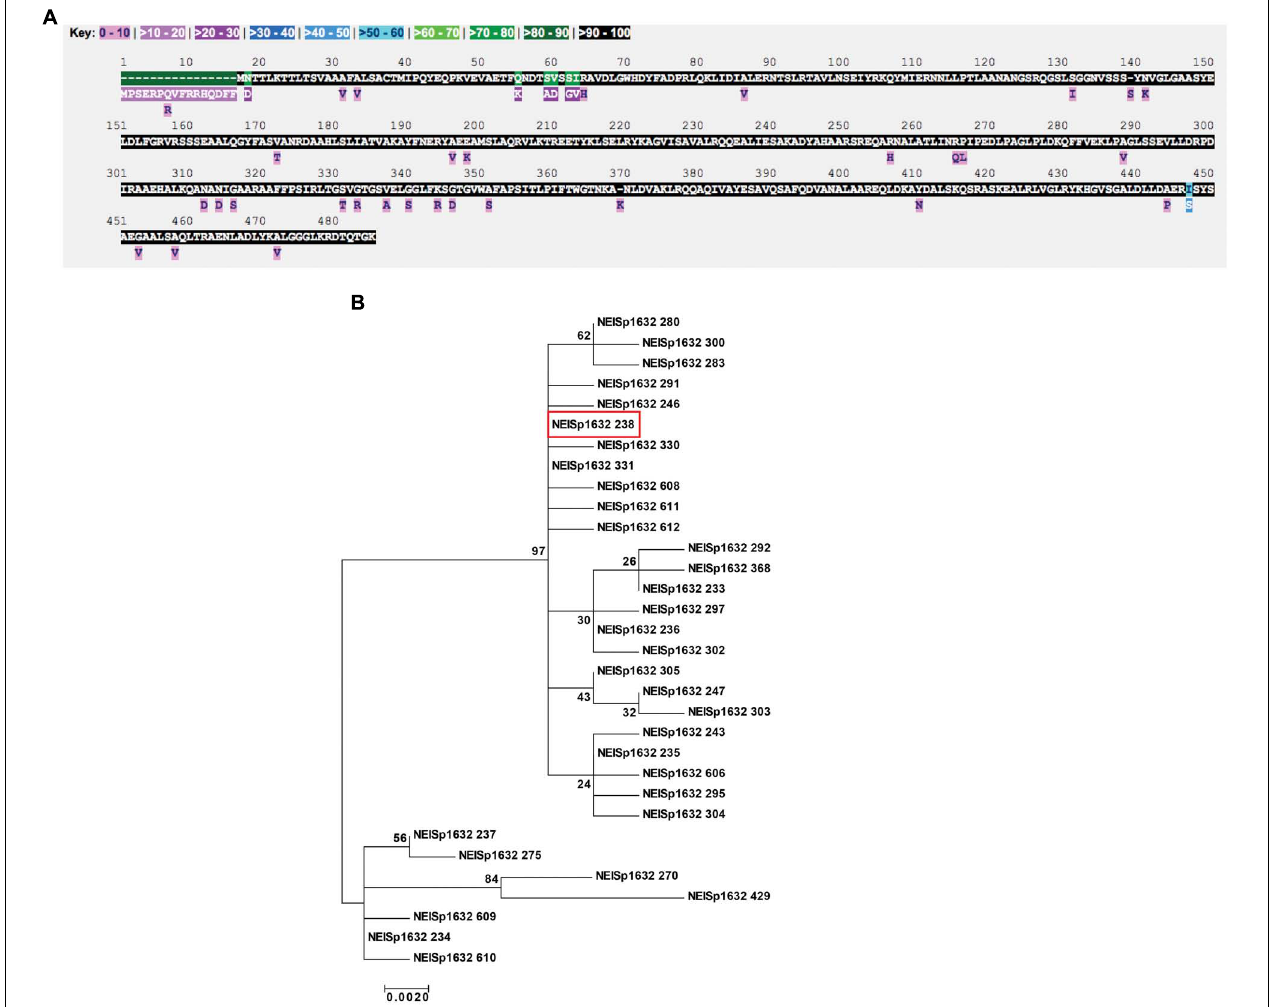
FIGURE 2 | Polymorphism and phylogenetic analyses of N. gonorrhoeae MtrE. (A) Inspection of MtrE amino acid polymorphisms across 3,908 N. gonorrhoeae isolates for which data exists for the NEISp1632 locus revealed the presence of 32 variants with 53 polymorphic sites across the 485 positions in the polymorphism analysis. (B) Phylogenetic analysis of the amino acid sequences revealed the two clusters of variants with the main cluster comprised of 25 variants, including the most common gonococcal variant, 238, shown in red